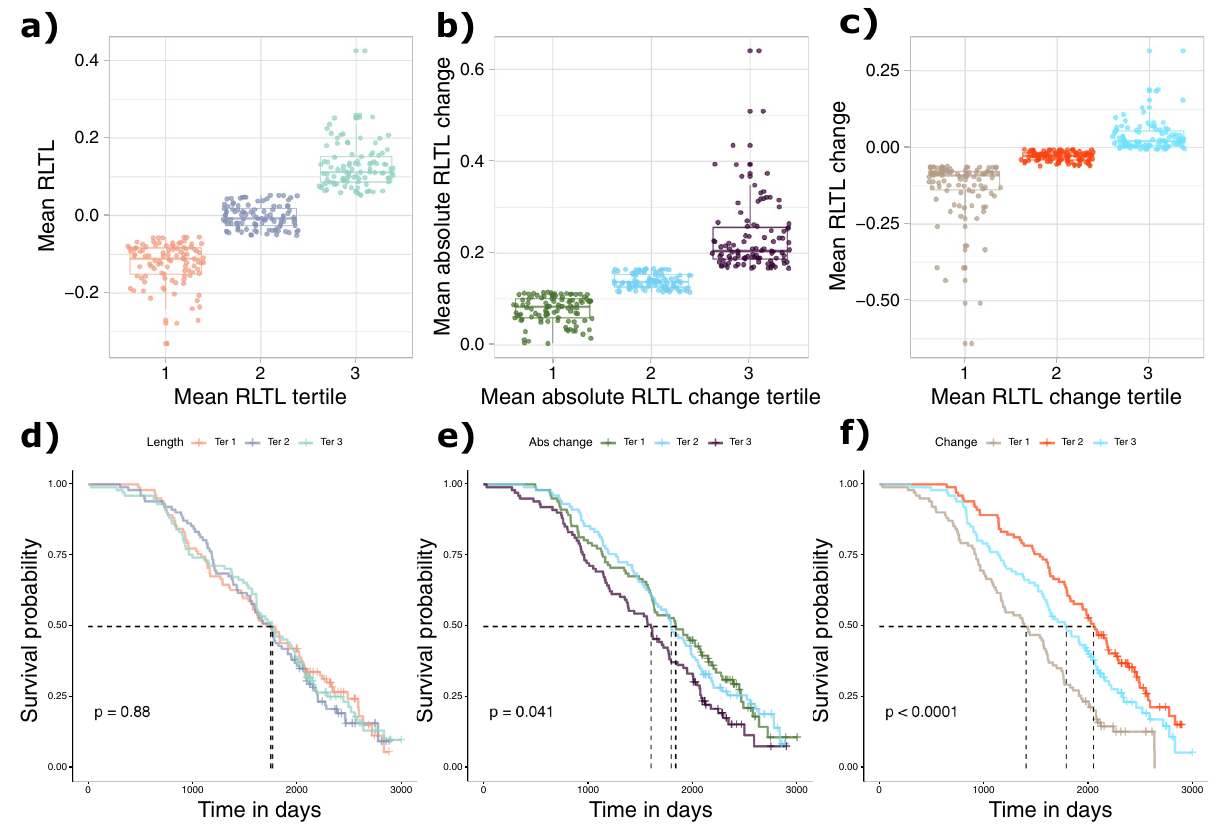
Figure 3. Relationship between lifetime telomere length dynamics and productive lifespan. RLTL measurements were grouped into tertiles as shown for ( a ) mean RLTL, ( b ) mean absolute RLTL change and ( c ) mean RLTL change. Kaplan–Meier curves show relationship of lifetime RLTL dynamics tertiles with productive lifespan. ( d ) Greater lifetime mean RLTL (tertile 3) was not significantly differently associated with productive lifespan than moderate or short lifetime mean RLTL (tertiles 2 and 1). ( e ) Greater mean absolute RLTL change (tertile 3) measured over the lifetime was associated with shorter productive lifespan compared to animals with moderate (tertile 2) or little (tertile 1) mean absolute RLTL change. ( f ) Greater mean lifetime RLTL attrition was associated with shorter productive lifespan. It can be seen that the mean survival of the group with the most RLTL attrition was about 600 days shorter than the mean survival of the group showing the most stable RLTL with neither dramatic shortening nor elongation (tertile 2).